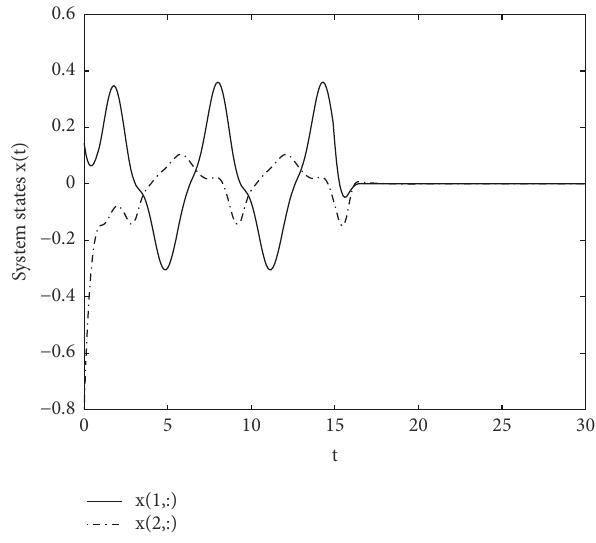
Figure 1: The response curve of system states 𝑥 1 , 𝑥 2